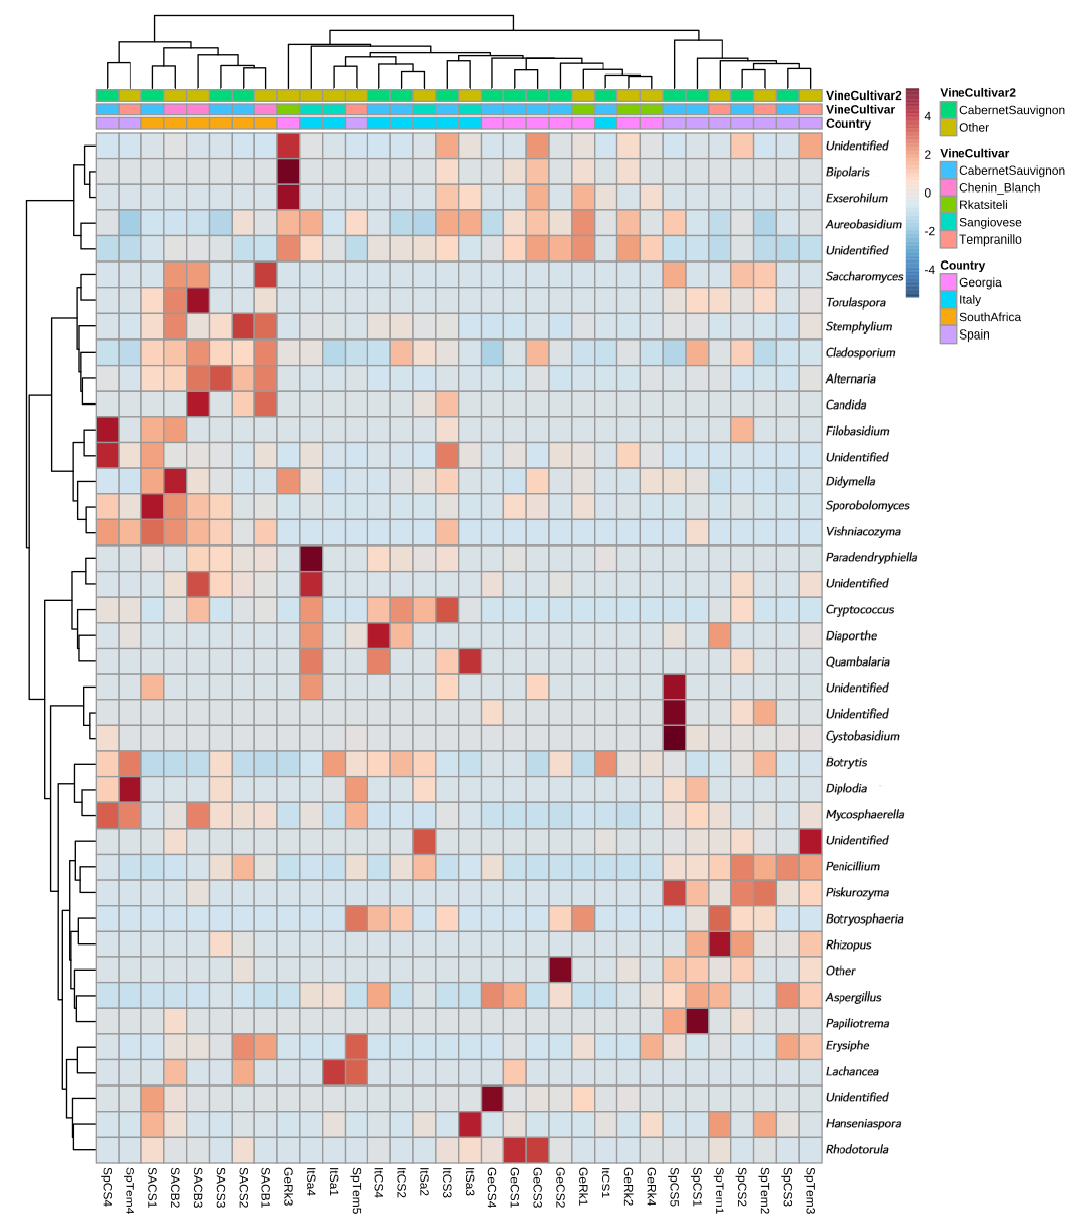
Figure 3. Clustered heatmap showing the variation of genus abundance with regard to vine cultivars and countries. Sample code: Ge, Georgia; It, Italy; SA, South Africa; Sp, Spain; CS, Cabernet Sauvignon; Rk, Rkatsiteli (Ge); Sa, Sangiovese (It); Tem, Tempranillo (Sp); CB, Chenin Blanc (SA).